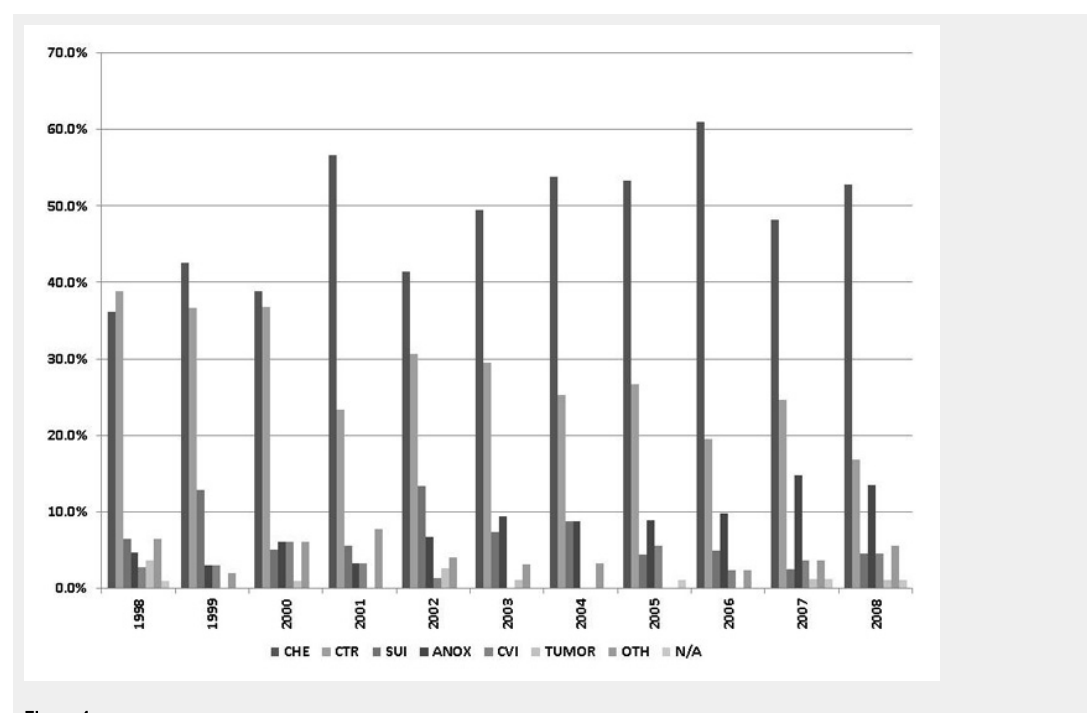
Figure 4 Causes of death (percentage) of the donors per